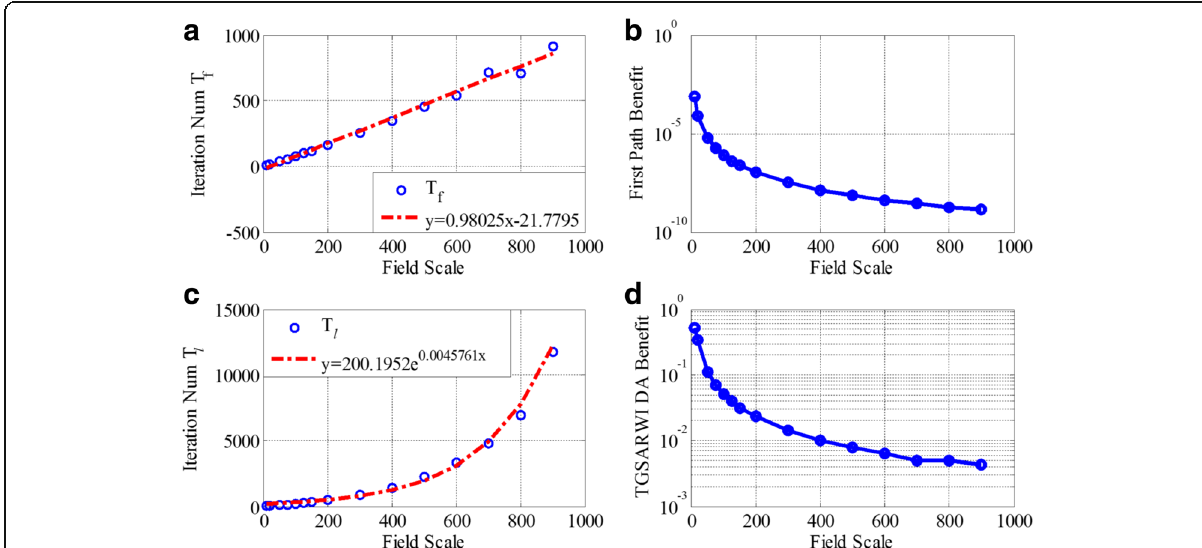
Fig. 10 The time computation complexity of TGSARWI with various field scales. a Shows the trend of iteration number of the first path obtained by TGSARWI. b Shows the trend of the first path benefit. c Shows the trend of iteration number for finding all the required connected paths. d Shows the benefit trend of iteration number for finding all the required connected paths